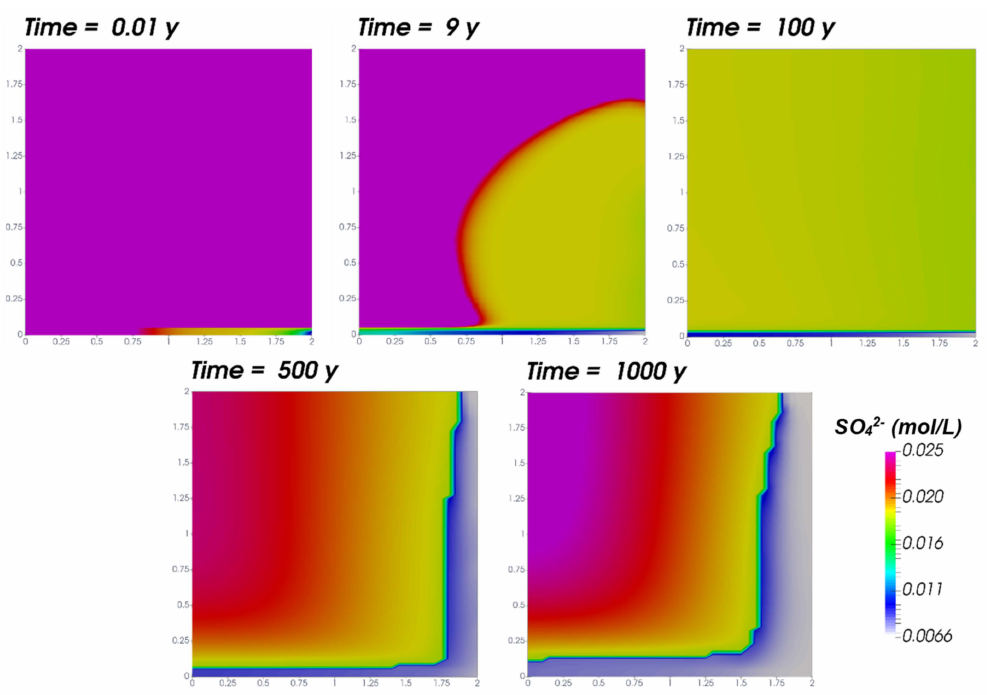
Figure 6. Spatial distribution of the computed concentration of dissolved SO 42 − at selected times of the simulation of scenario